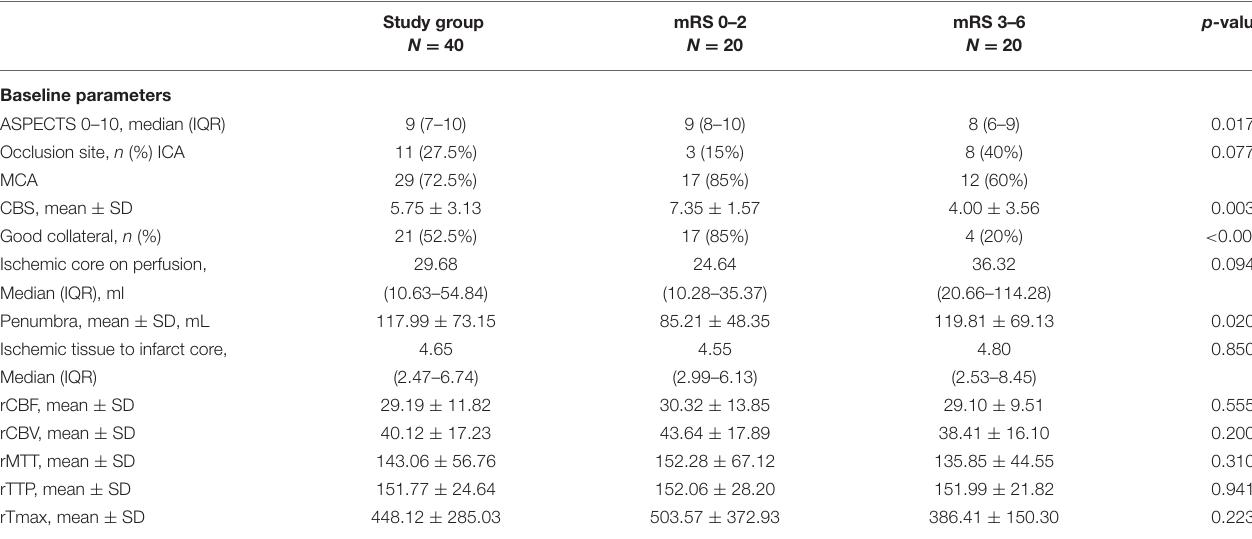
TABLE 2 | Imaging characteristics ( n =